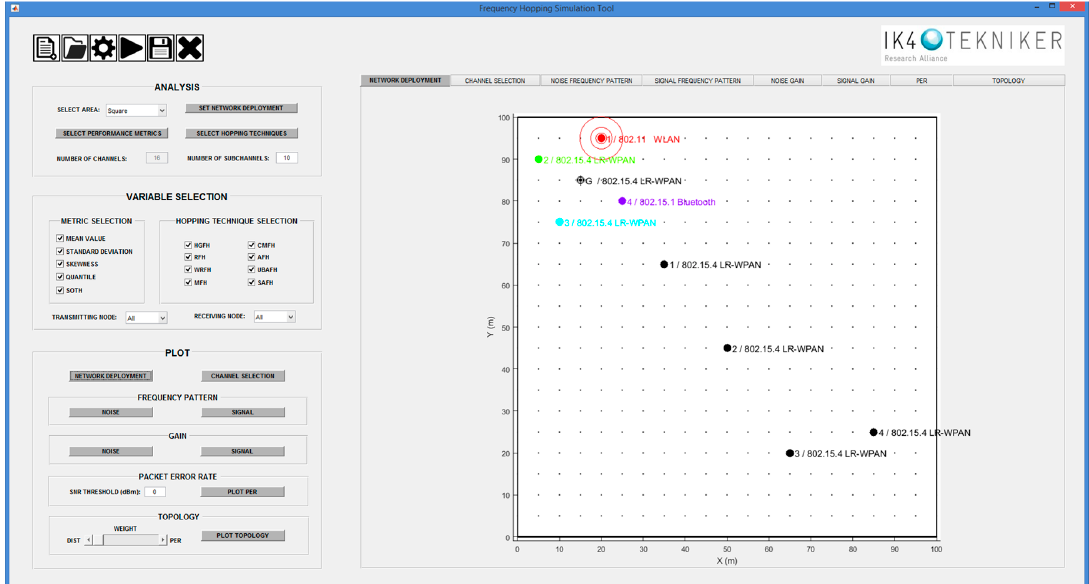
Figure 16. Main interface of the simulation tool. The left panels contain buttons to configure the analysis parameters and select the different plotting options. The right panel is reserved for the graphical representation of the results. The different type of results are represented in their corresponding tab within the graph panel.